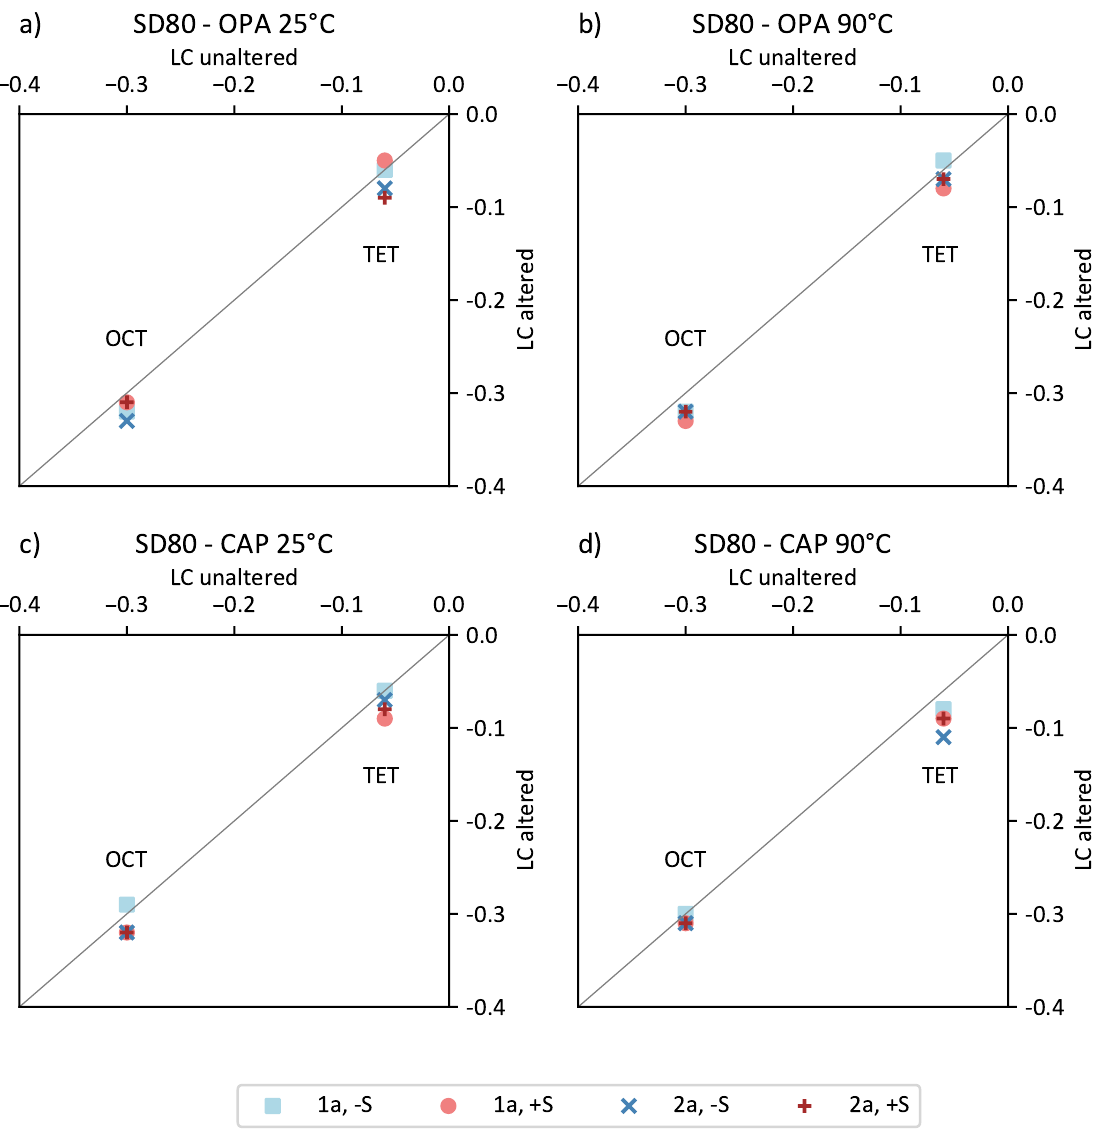
Figure 10. Scatter plots for SD80 smectites that compare the altered tetrahedral (TET) and octahedral (OCT) charges to the initial charge distribution for samples reacted in ( a , b ) Opalinus clay pore water (OPA) and ( c , d ) diluted cap rock solution (CAP). Overall, only minor changes were observed after experimentation. LC: layer charge, − S: control samples without substrate, +S: samples with